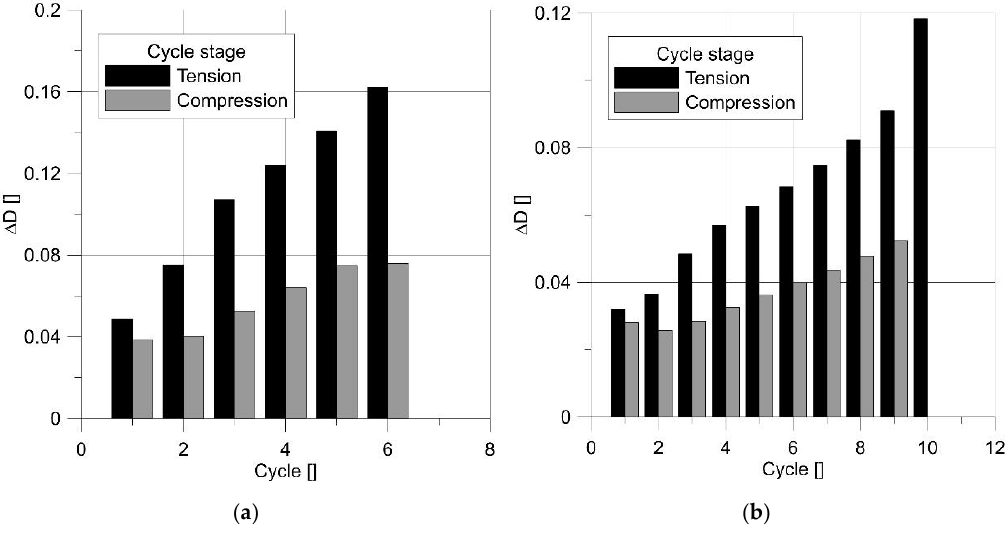
Figure 22. Increment of parameter D for subsequent cycles.